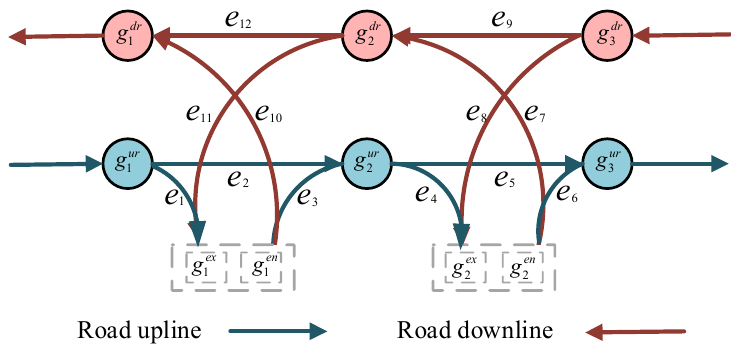
Figure 2. Arch-bridge topology.